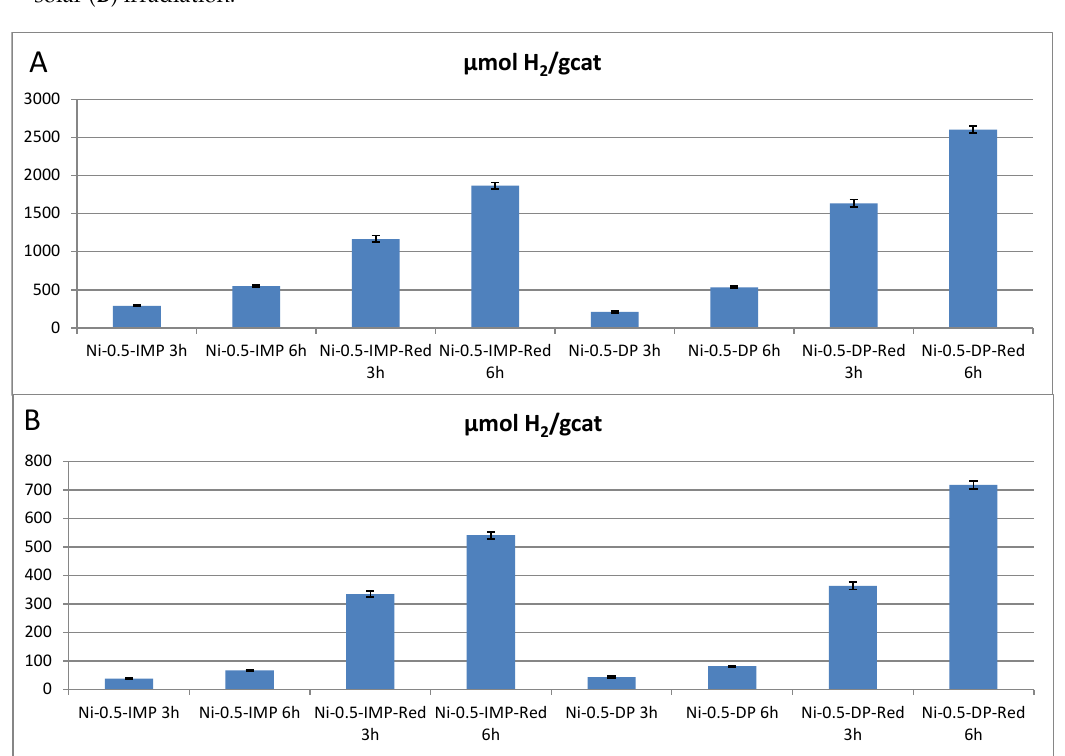
Figure 7. H 2 production from glycerol photo-reforming on fresh, unreduced solids using UV ( A ) and solar ( B ) irradiation.